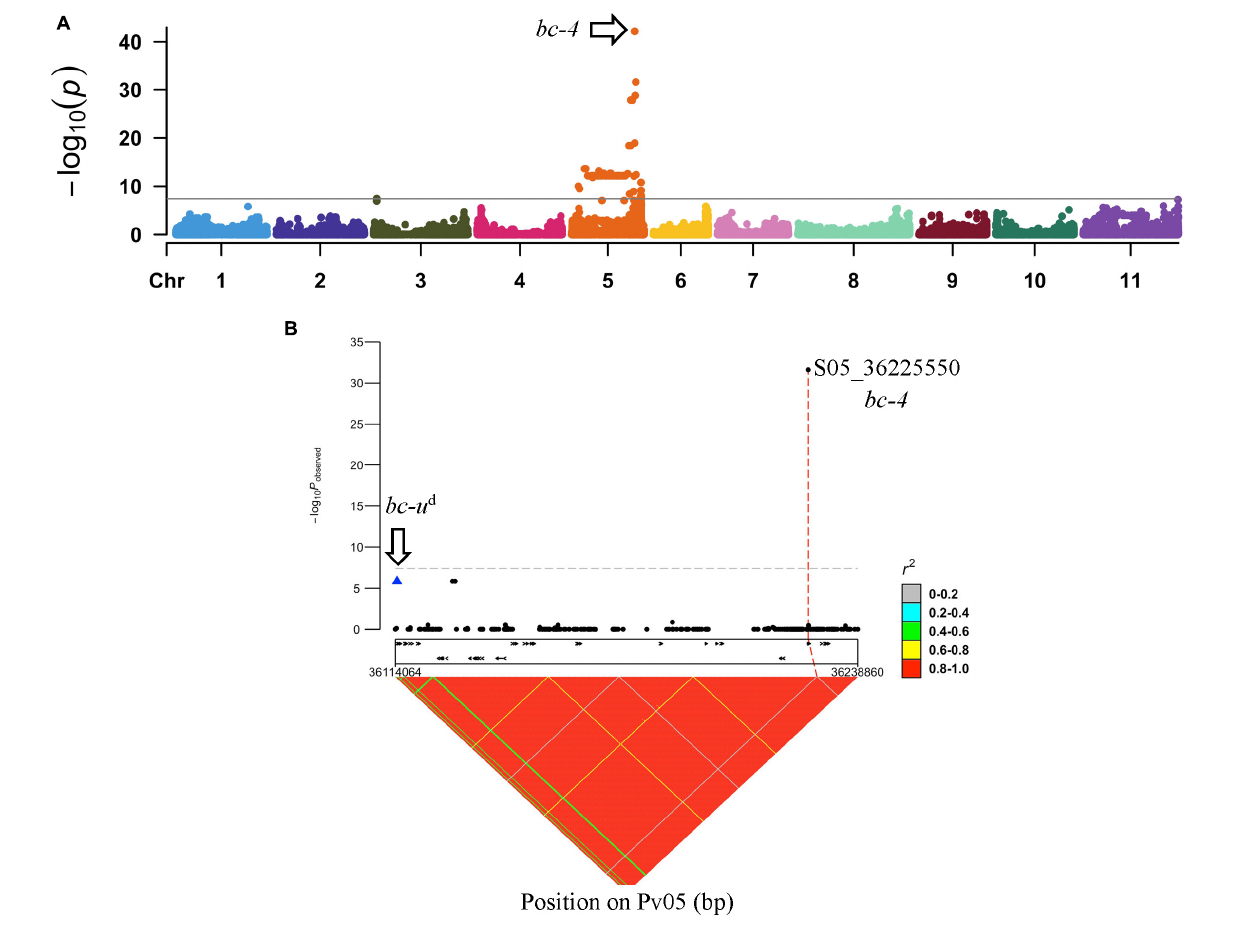
FIGURE 3 | GWAS between DDP lines with no symptoms to US-6 strain vs. DDP lines exhibiting mosaic (M), TN, mM, or VN against NL-3. (A) Manhattan plot from GWAS in DDP lines exhibiting a significant peak on Pv05. (B) bc-4 regional association plot showing linkage (in repulsion) between bc-u d and bc-4 (S05_36225550).